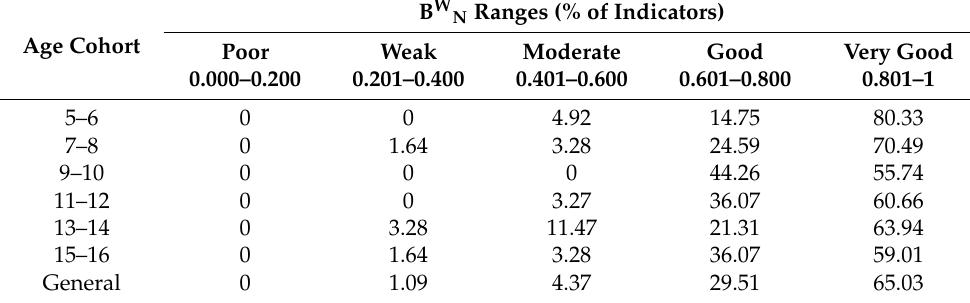
Table 3. Judges’ agreement size (age